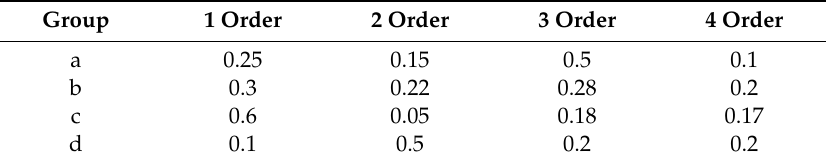
Table 1. The weight of harmonics of the modulation frequency.